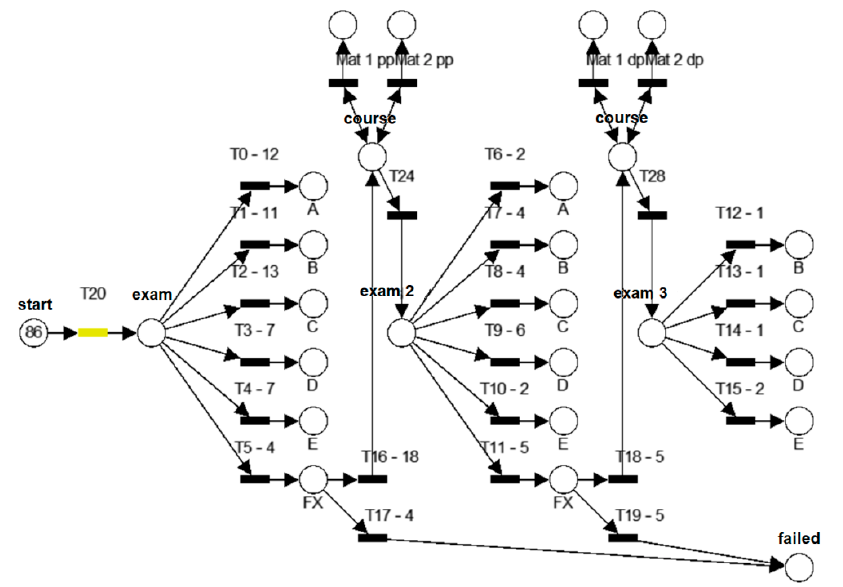
Figure 12. Model of the final exam with the observation of the study.